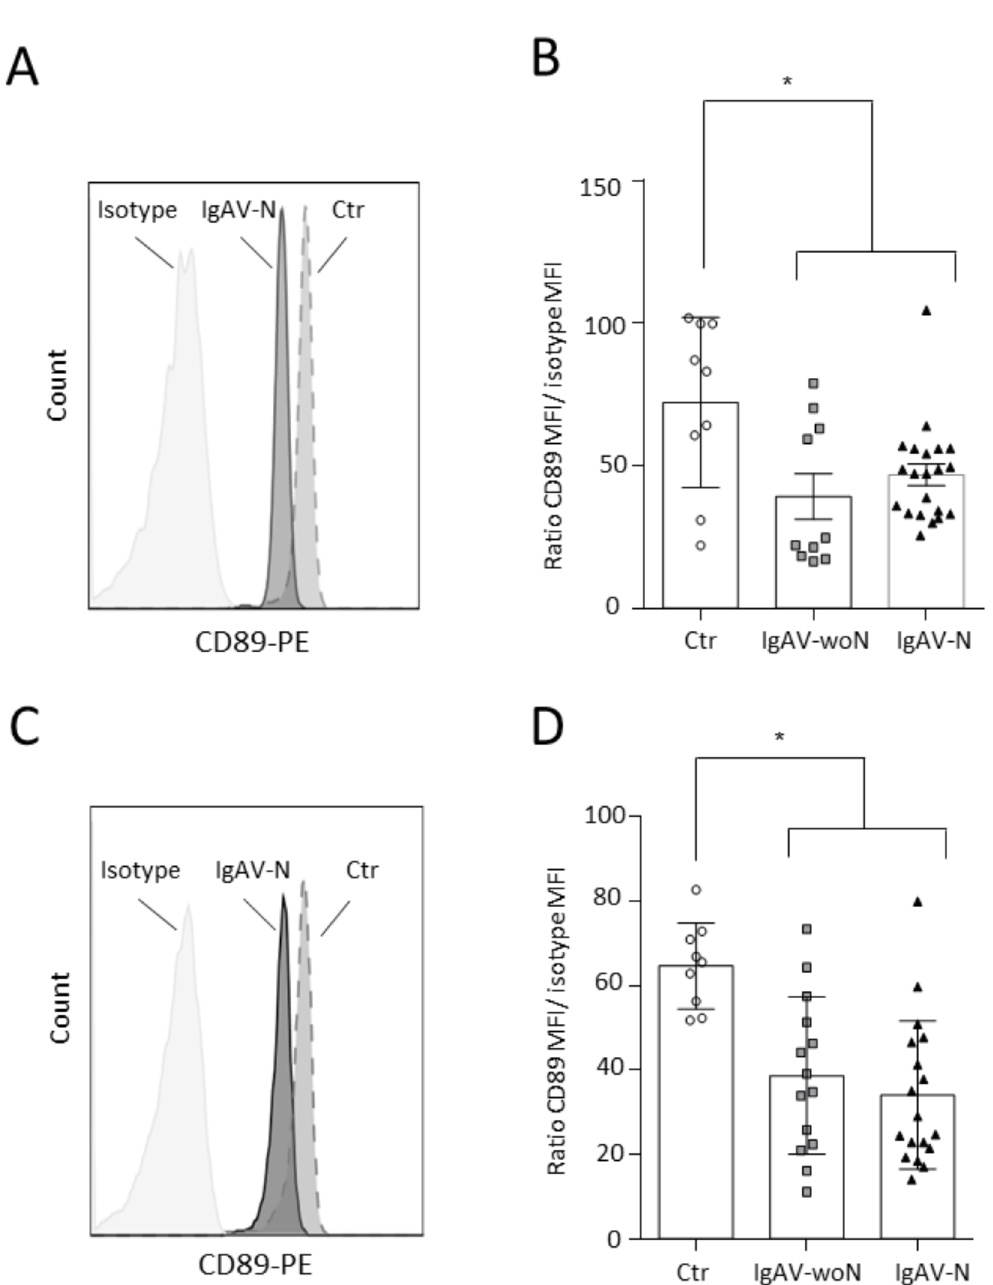
Fig 3. CD89 expression on blood granulocytes and monocytes. (A) Representative histogramof CD89 expressionon granulocytes. (B) Ratio of the CD89mean fluorescence intensity (MFI) / isotype MFI on blood granulocytes. (C) Representative histogram of CD89 expressionon monocytes. (D) Ratio of the CD89 mean fluorescence intensity (MFI) / isotype MFI on blood